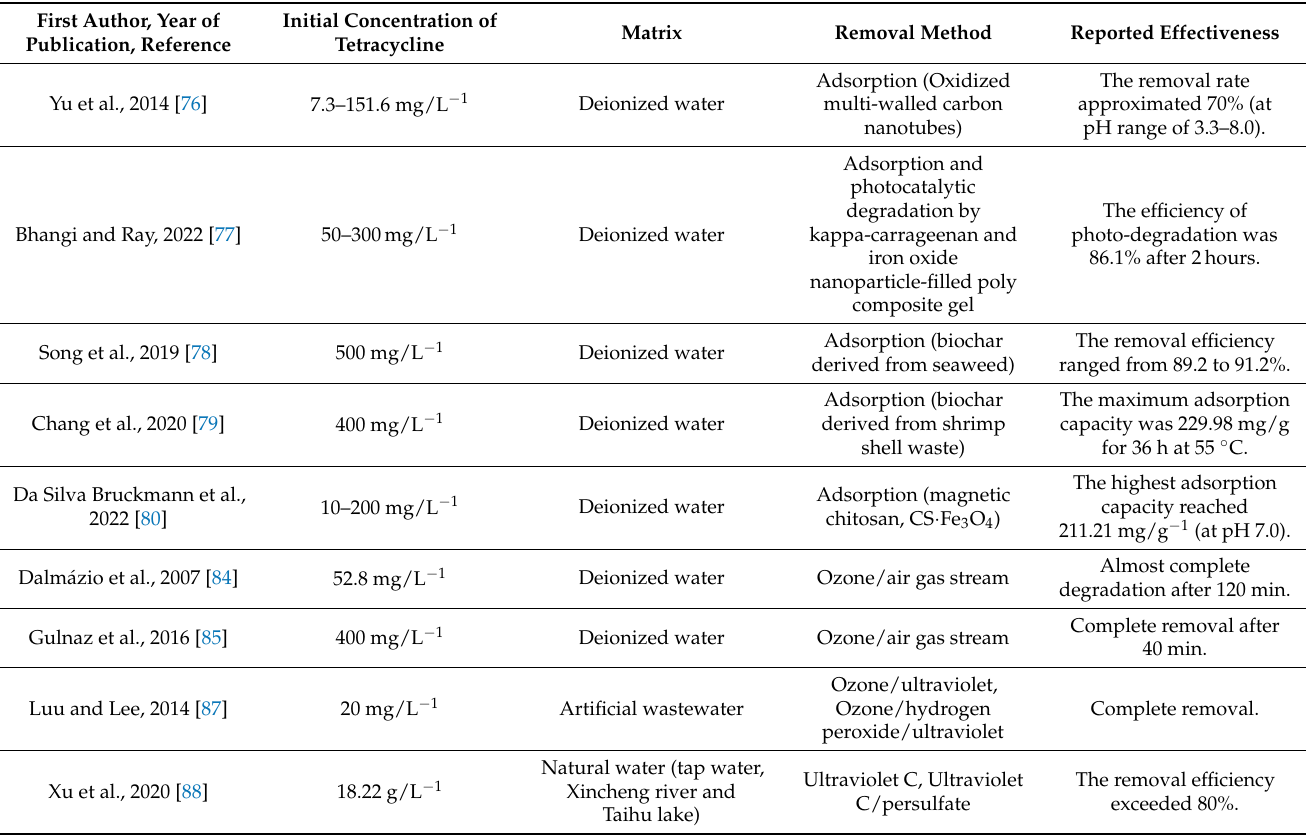
Table 1. Studies on the effectiveness of adsorption and photodegradation methods in removal of